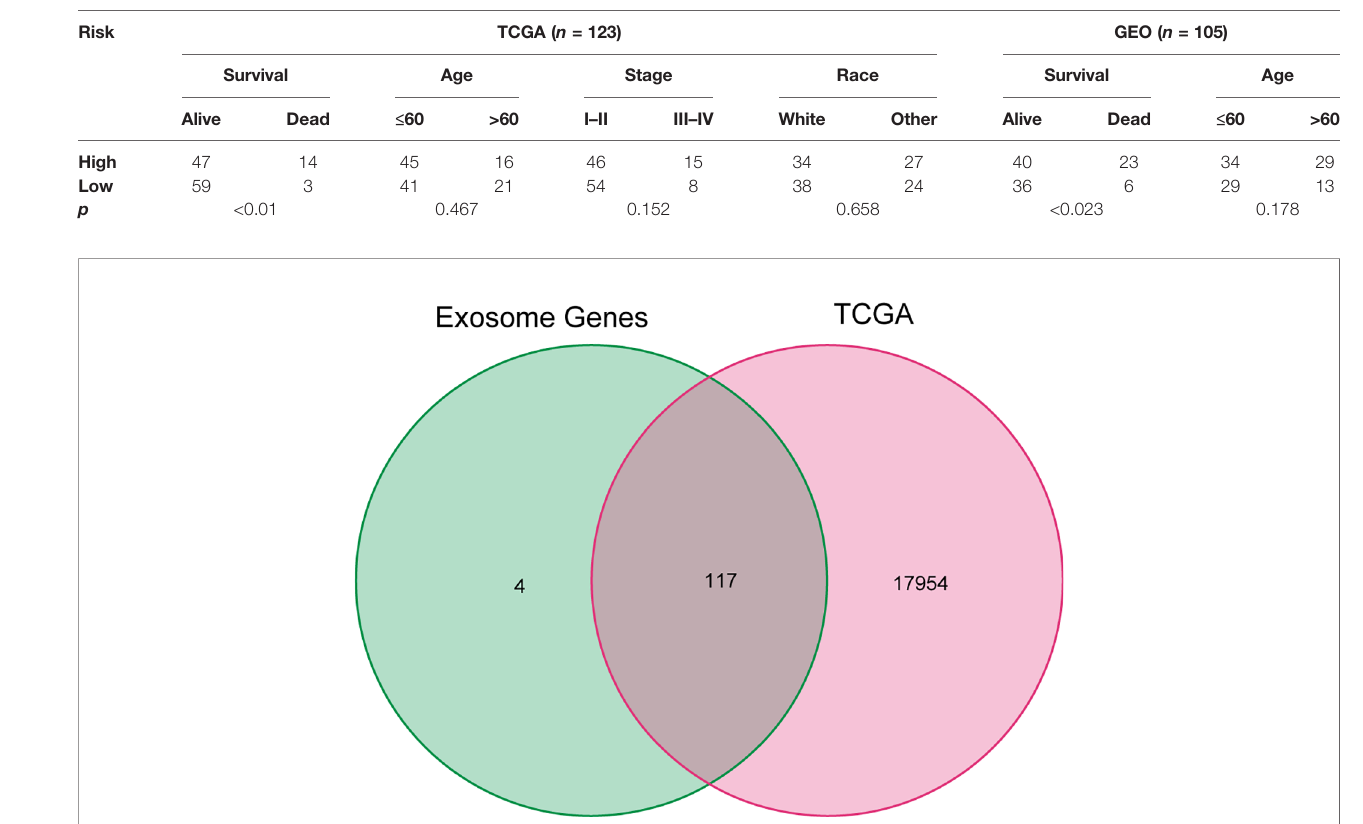
FIGURE 1 | Venn diagram of genes in TCGA cohort and exosome-related genes. The 121 exosome-associated genes were downloaded from ExoBCD database, of which, 117 genes related to exosome in the TCGA cohort were ascertained by Venn